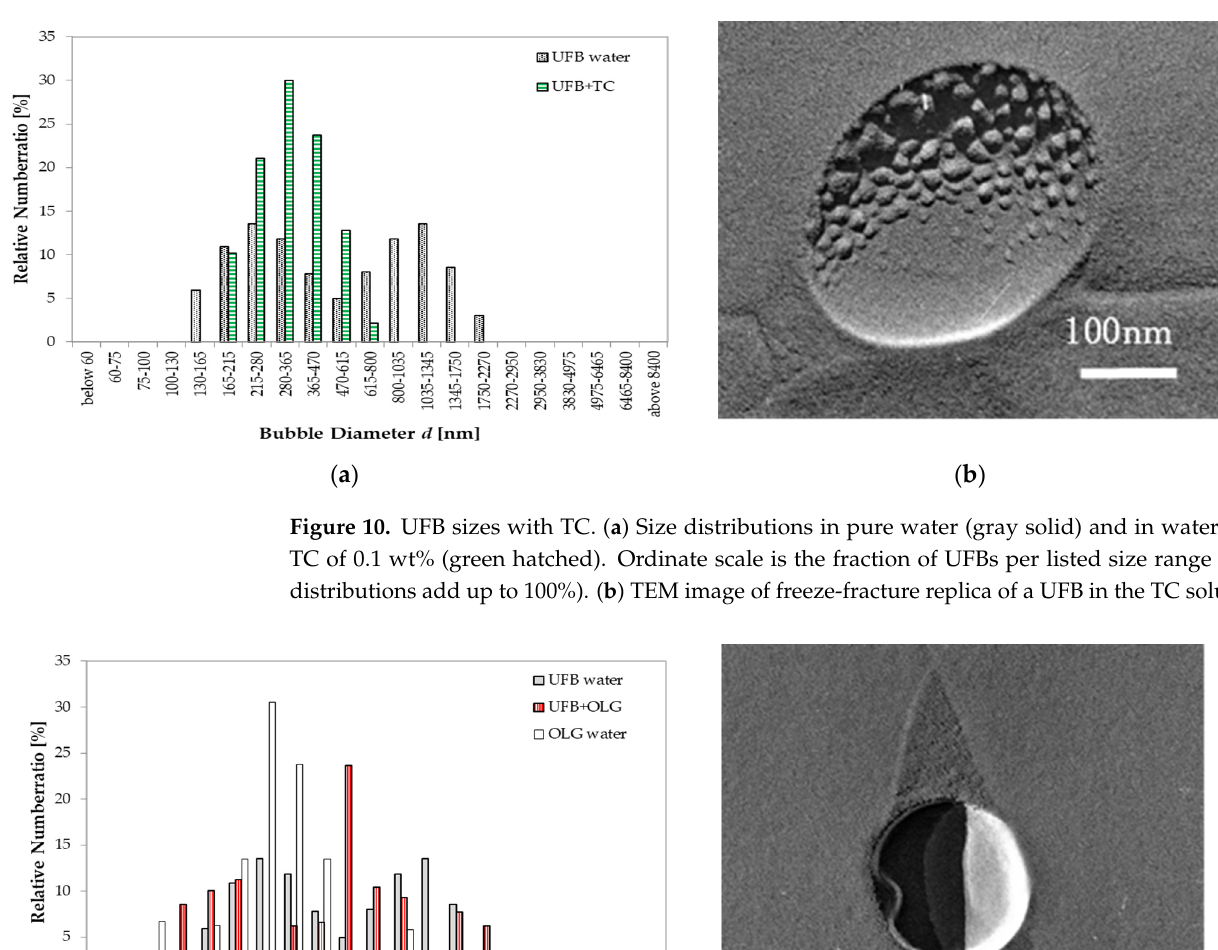
Figure 10. UFB sizes with TC. ( a ) Size distributions in pure water (gray solid) and in water with TC of 0.1 wt% (green hatched). Ordinate scale is the fraction of UFBs per listed size range (both distri-